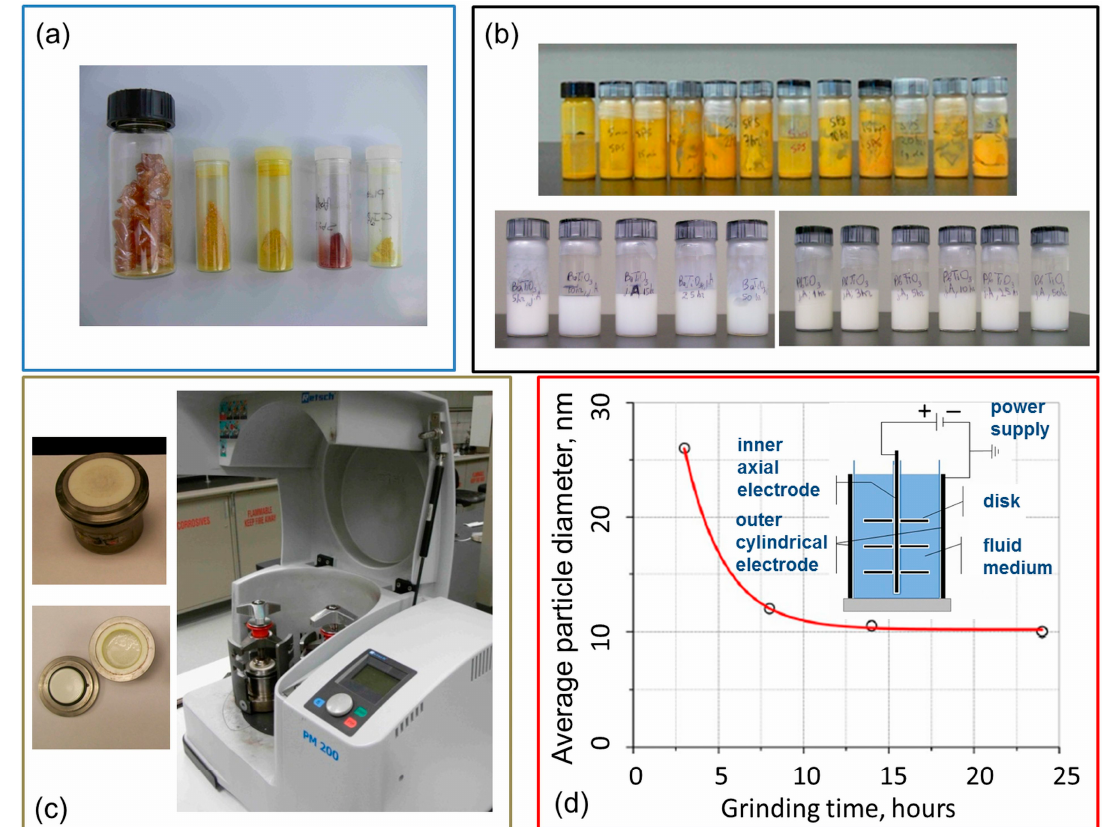
Figure 3. ( a ) Macro-crystals prior to milling; ( b ) The obtained dispersion of milled ferroelectric nanoparticles in a fluid carrier (heptane); ( c ) Commercially available high-energy ball mill; ( d ) an average size of the milled nanoparticles vs. grinding time [8]. A typical harvesting setup is shown in the inset (redrawn after [125]).